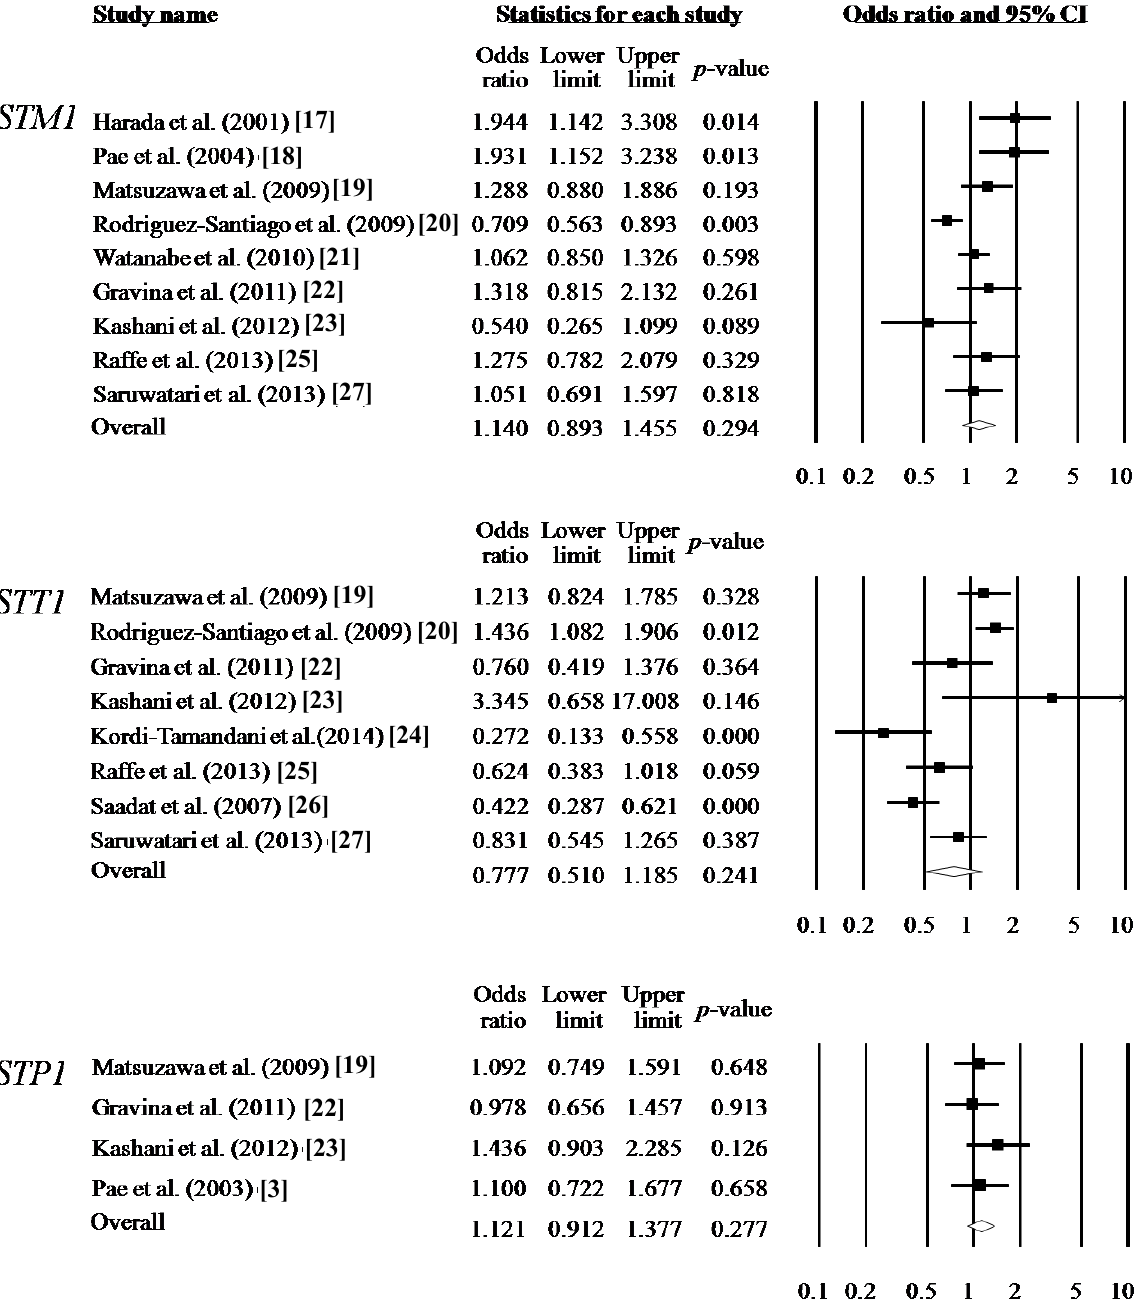
Figure 1. Odds ratio and 95% CIs are presented for individual studies (black square and line) and meta-analysis results (diamond). ( A ) Analysis of null type vs . present type of GSTM1 polymorphism; ( B ) Analysis of null type vs . present type of GSTT1 polymorphism; ( C ) Analysis of Val allele vs . Ile allele of GSTP1